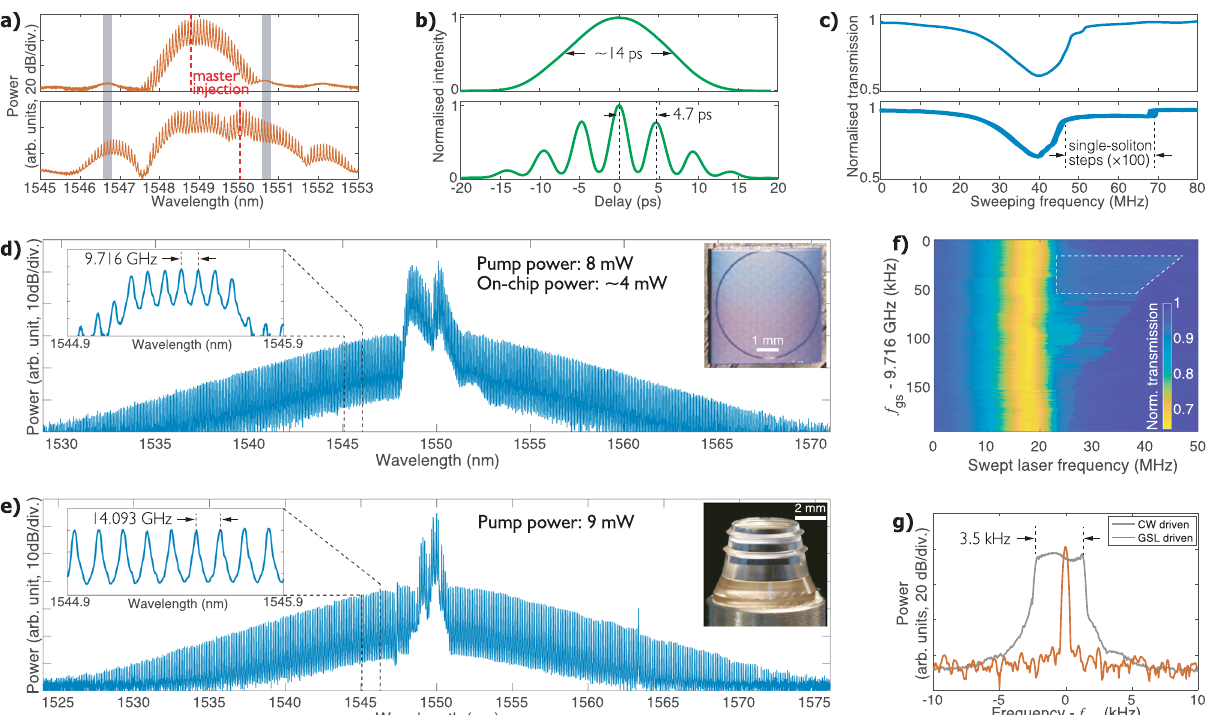
Fig. 2 Soliton microcomb generation with a gain-switched distributed feedback laser. a The GSL spectra when the master laser is injected at the central lasing position (upper panel) and an off-central-mode frequency (lower panel). The grey stripes indicate the positions of the two adjacent longitudinal modes. The red dashed lines show the wavelengths of the master laser. b The intensity autocorrelation of the GSL pulses when the DFB laser is central- mode-injected (upper panel) and off-centre-injected (lower panel), respectively. c Laser downsweeping transmission traces corresponding to the central- mode-injected operation (upper panel) and off-centre-injected operation (lower panel), respectively. In the lower panel, 100 consecutive sweeping traces are overlaid. The offset-centre injection locking leads to signi fi cantly longer soliton steps. d , e The microcomb spectra of a Si 3 N 4 microring resonator and an MgF 2 crystalline resonator. The left-hand insets show the enlarged portions of the spectra (band-pass- fi ltered for the Si 3 N 4 microcomb). The right-hand insets are the photographs of the microresonators. f Contour plot of the laser-frequency-swept transmission as the gain-switching frequency f gs is varied. The trapezium outlined by dashed lines indicates the area for a robust single-soliton generation. g Spectra of f rep when the laser-resonance detuning is swept, showing that the microcomb repetition frequency is changing in CW pumping but governed by f gs in the GSL-driven situation. The measurement resolution bandwidth (RBW) is 100